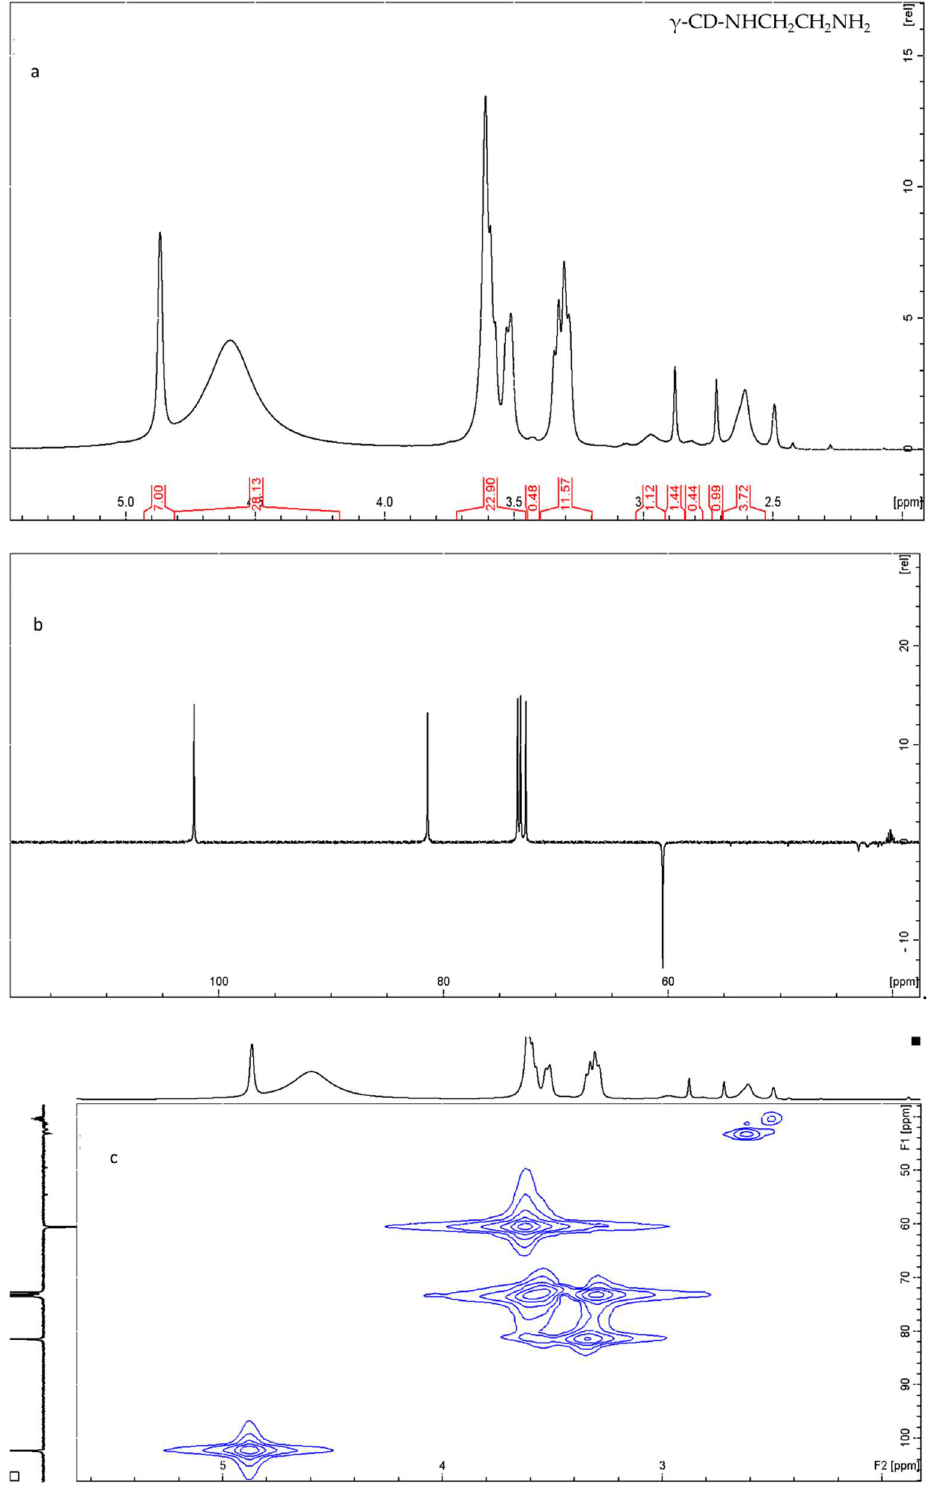
Figure 2. ( a ) 1 H-NMR spectrum, ( b ) 13 C-dept 135-NMR spectrum, and ( c ) 1 H- 13 C-HMQC-NMR for γ-CD-NHCH 2 CH 2 NH 2 in 80% d 6 -DMSO and 20% D 2 O at 25 °C. The thermal profiles of γ-CD, γ-CD-NHCH 2 CH 2 NH 2 , γ-CD-NHCH 2 CH 2 OH, and γ- CD-NH 2 are shown in Figure 3, with the temperature ranging between 30 °C and 400 °C. The thermal change occurred between 30 °C and 100 °C in different γ-CDs, due to the